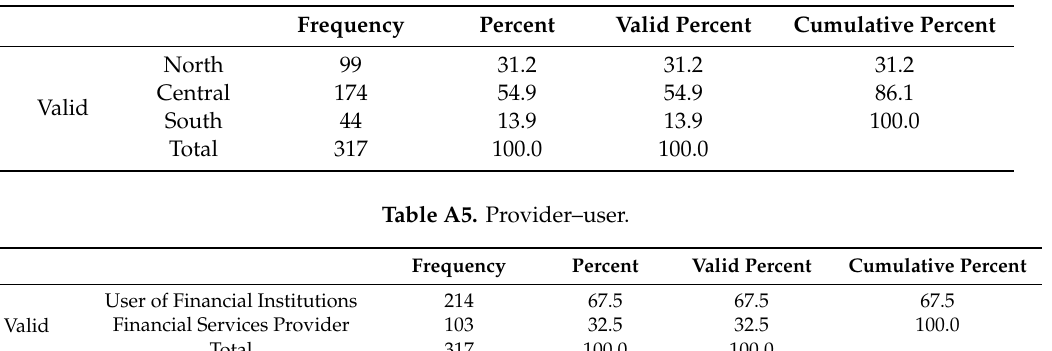
Table A4. Locality.